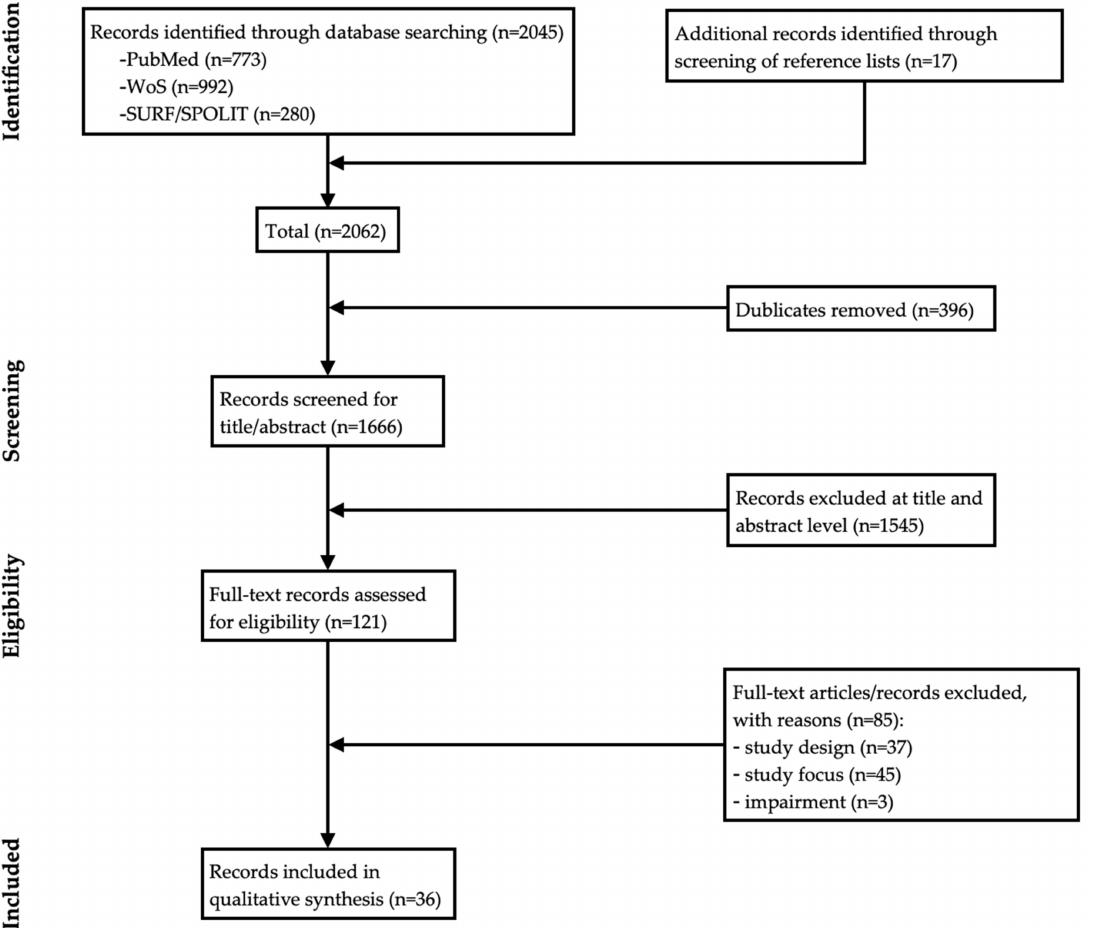
Figure 1. PRISMA [49] flow diagram illustrating the systematic search and review